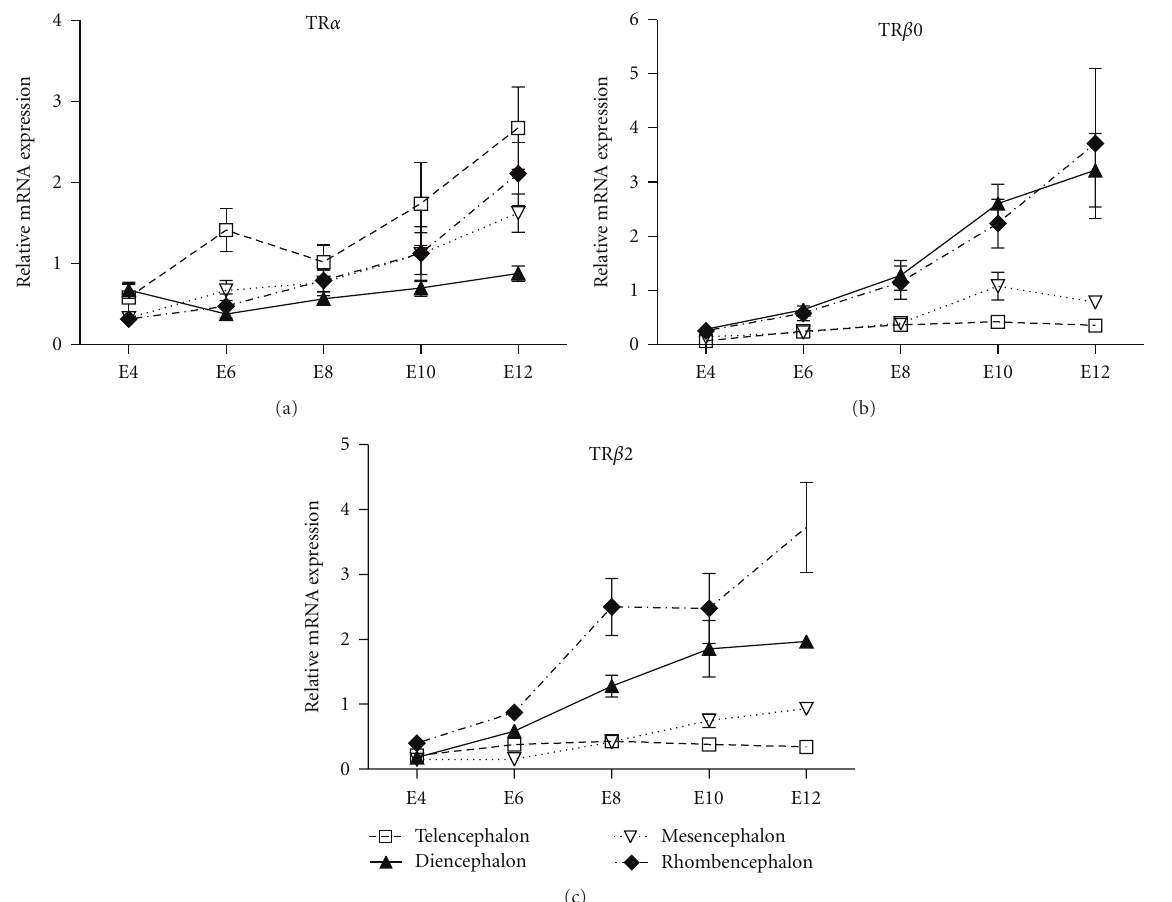
Figure 2: Ontogenetic pattern of TR α , TR β 0, and TR β 2 expression in di ff erent brain regions of 4- to 12-day-old chick embryos. Specific mRNA levels were measured by qRT-PCR and normalised against a combination of four housekeeping genes: β actin, GAPDH, β 2 microglobulin, and cyclophilin A. Values represent the mean ± SEM for 6 independent samples per